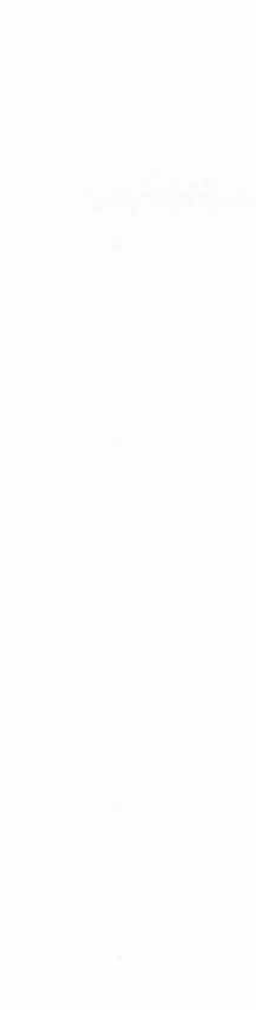
Fig.lO: (a} Schematic diagram of flow behaviour in an ice sheet. Biaxial compression dominates in the vicinity of the ice divide, while simple shear is obtained near the basal surface. The solid lines represent particle trajectories, while the dashed curves are lines of constant age. Between the two dashed-dotted lines, a mixture of deformation types is observed. (b) Material elements which are originally spheres and are de­ formed into ellipses during